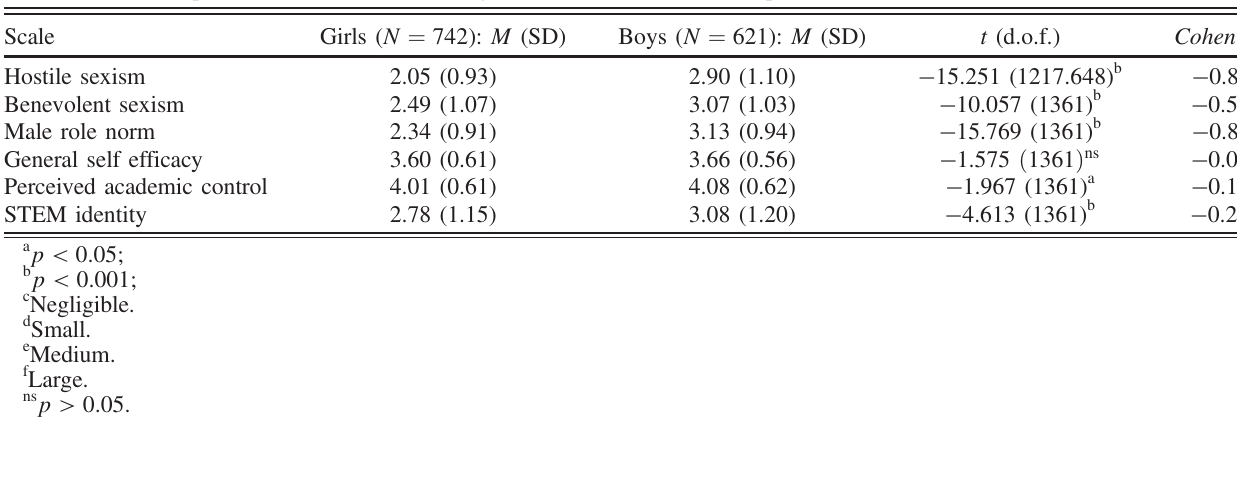
TABLE II. Descriptive statistics with t test for gender differences on the adopted scales.